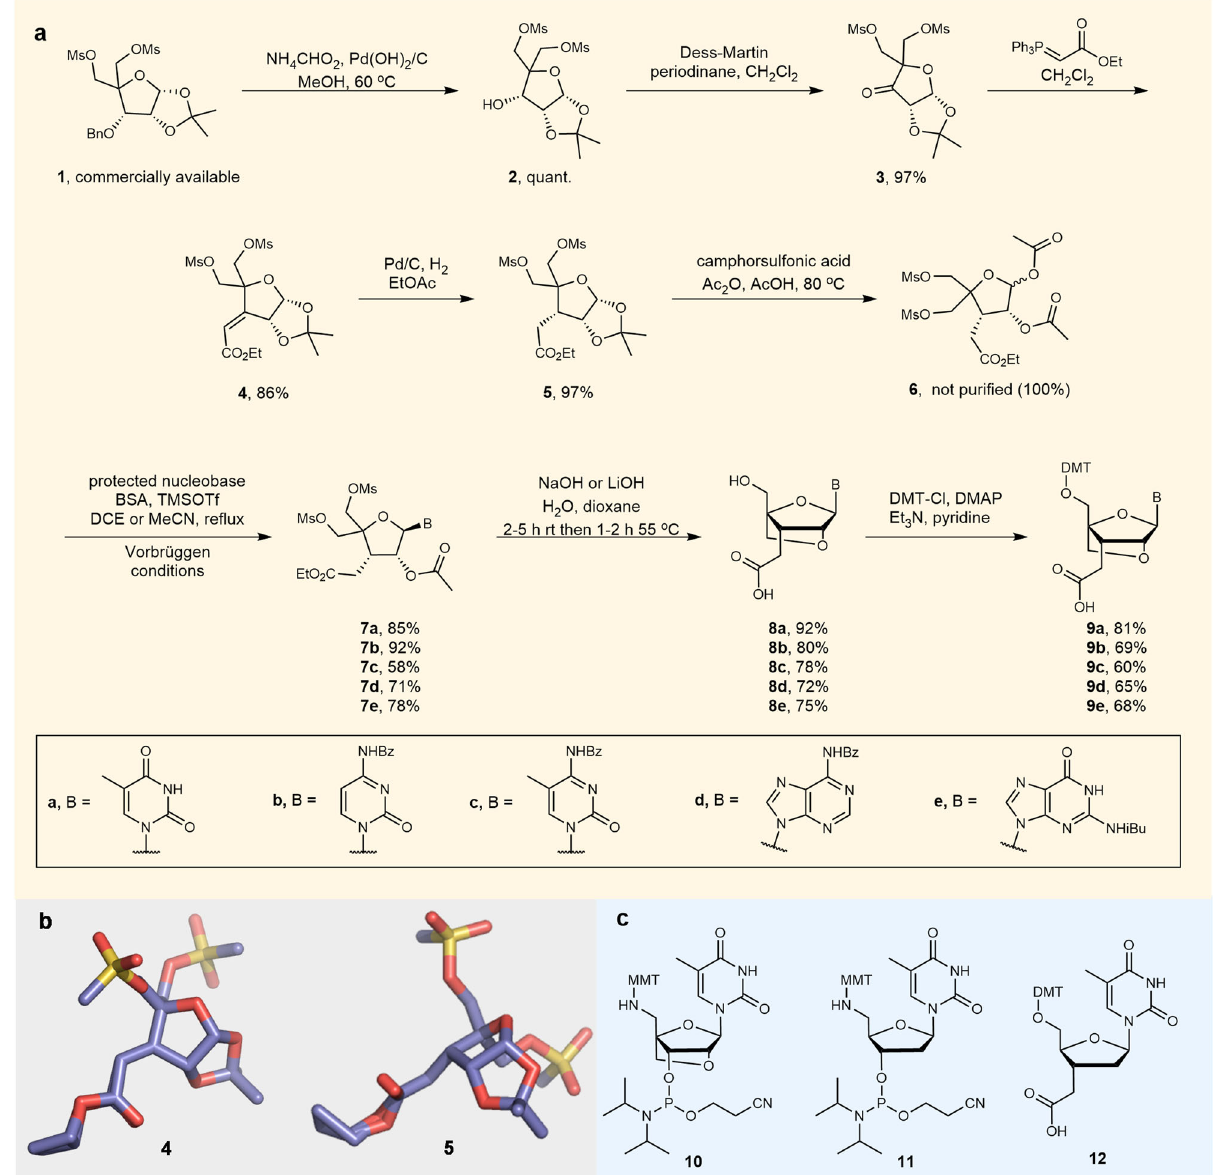
Fig. 2 LNA-ethanoic acids and other monomers used in this study. a Synthesis of the DMT-protected LNA-ethanoic acids 9a – e . b X-ray crystal structures con fi rming the (E)-con fi guration in 4 and the stereochemistry at the 3 ′ -carbon in 5 (details in 'Small molecule crystallography' section in the Supplementary Information). c Phosphoramidites 10 47 and 11 (commercially available) and DNA-ethanoic acid monomer 12 48,49 are used to synthesise oligonucleotides. BSA bis(trimethylsilyl)acetamide, TMSOTf trimethylsilyl tri fl uoromethanesulfonate, DMAP